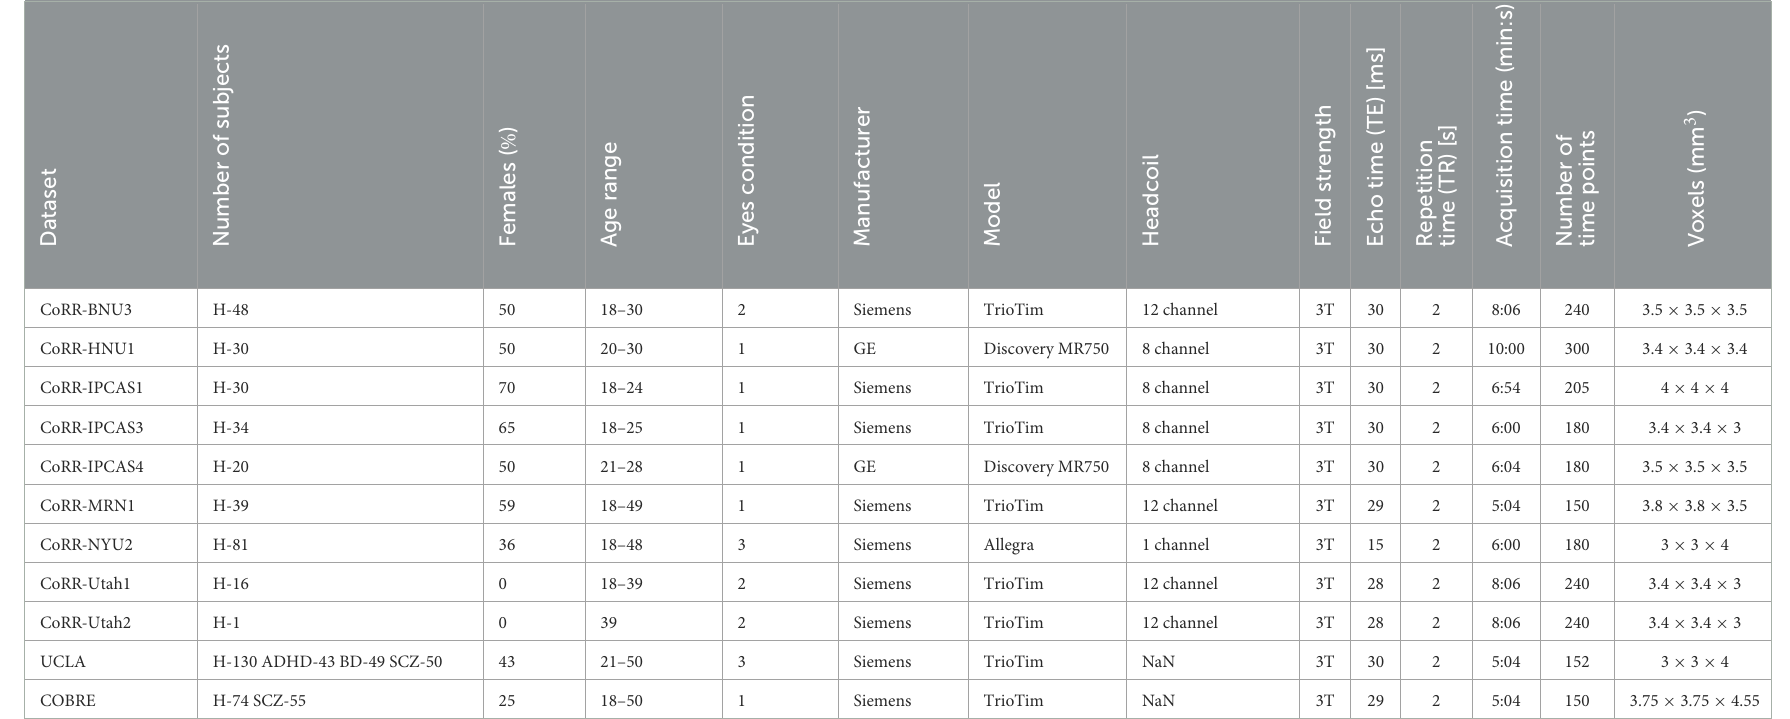
TABLE 1 Information about the data that were selected for the subsequent